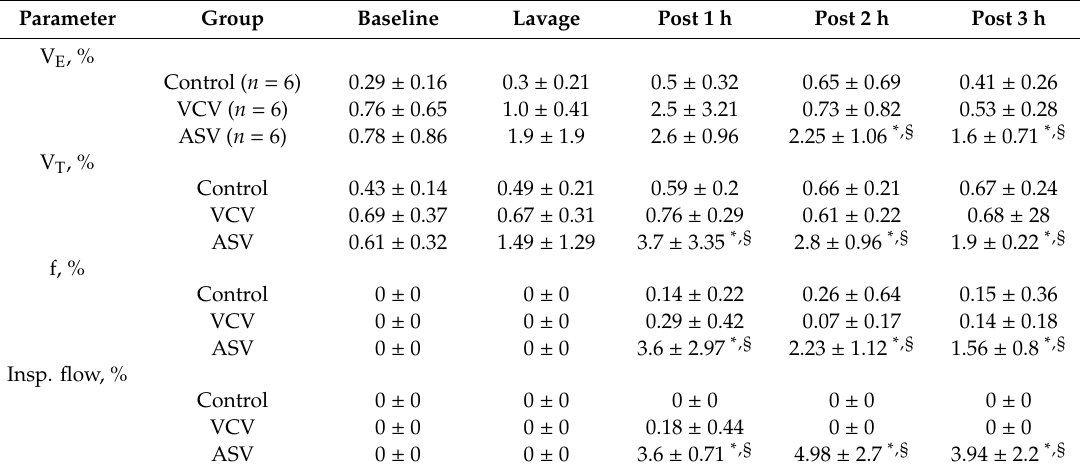
Table 3. Coe ffi cients of variance in di ff erent group breathing